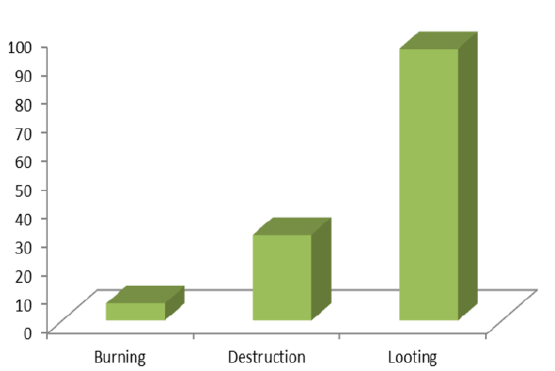
Figure 2: Graphical representation of Damage in Schools